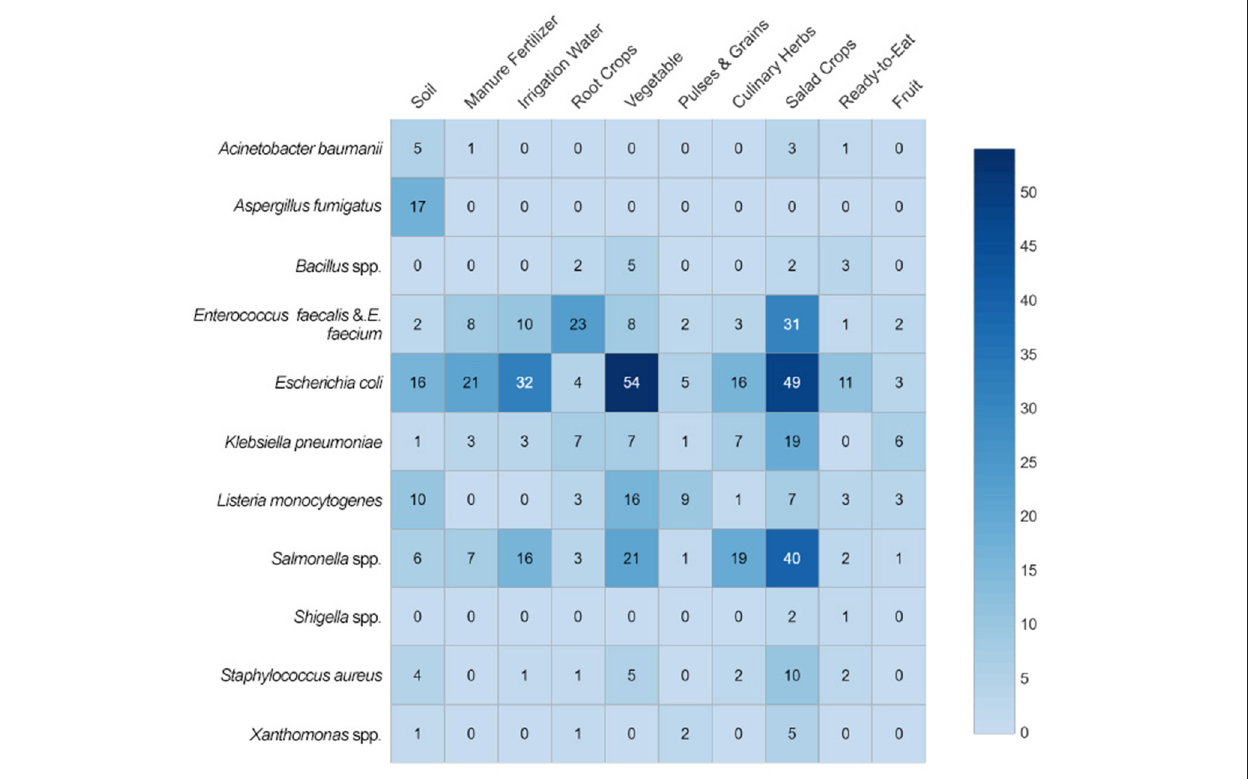
Antibiogramme - Société Française de Microbiologie (CA-FSM, n =